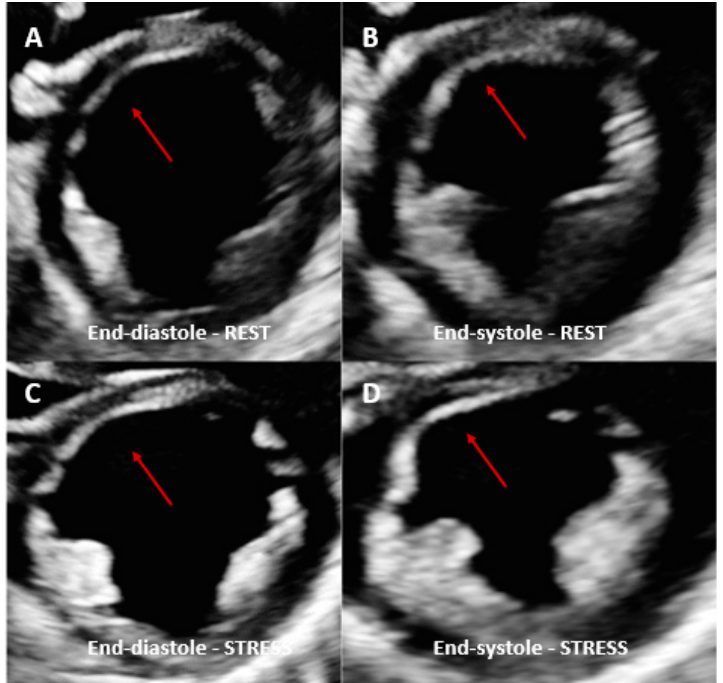
Figure 1. Dobutamine stress echo performed in a patient with coronary artery vasculopathy (CAV). End-diastolic rest images ( A ) demonstrated a thinned anterior septal area compared to the other myocardial segments (red arrows) and not thickening during systole ( B ). Same view acquired at peak dobutamine stress ( C , D ) demonstrated no significant changes in the same area with no other regional wall motion abnormalities identified. Angiography was therefore performed, showing se- vere left anterior descending coronary artery stenosis. 2.4. Limitations Despite the several advantages named so far, echocardiography has some limita- tions. Suboptimal acoustic windows can significantly decrease the quality of the images acquired, particularly in patients with previous chest surgery. Furthermore, the presence of left bundle branch block, pre-existing wall motion abnormalities, malignant cardiac ar- rhythmias (ventricular tachycardia, complete A-V block), hemodynamically significant LV outflow tract obstruction, and severe systemic hypertension are other important con- traindications. Finally, stress echocardiography needs adequate and specialized training compared to the rest of echocardiography, limiting the access to this modality at center with higher expertise [9,10]. 3. Stress Imaging in Pediatric Nuclear Cardiology Stress 3.1. Introduction Stress testing in nuclear cardiology for myocardial perfusion imaging involves a stress test (to assess myocardial perfusion) and a scintigraphic scan of the heart, with the administration of a radiopharmaceutical. Scintigraphic images are obtained after myocar- dial stress and in rest conditions [11] with the myocardial uptake of the radiolabeled tracer that depends on coronary flow, cell membrane integrity, and cell viability [11]. The main clinical indications of stress testing imaging in pediatric nuclear cardiology are represented by KD to evaluate myocardial ischemia and/or myocardial infarction (Fig- ure 2) [12,13], the assessment of coronary perfusion after the arterial switch operation for transposition of great arteries [14], the post-operative follow-up of children with anoma- lous origin of the left coronary artery from the pulmonary artery (to assess the extension